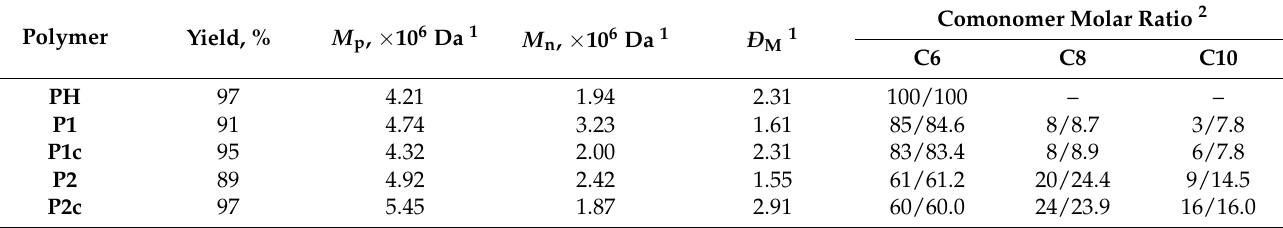
Table 2. The results of polymerization experiments.